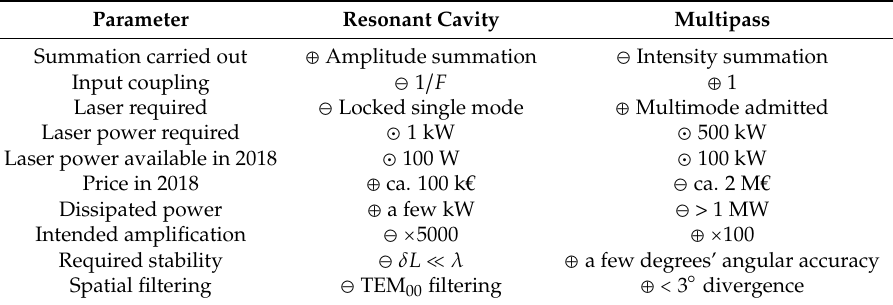
Table 1. The lesser ( ⊕ ), greater ( ⊖ ) or similar difficulties ( ⊙ ) of coherent amplitude summation in an optical cavity vs. incoherent intensity summation in a multipass cell. The orders of magnitude are estimated for a real-size neutral beam injector, with a kinetic energy of 1 MeV per D 0 atom, assuming that the width of the ion beam could be reduced to 1